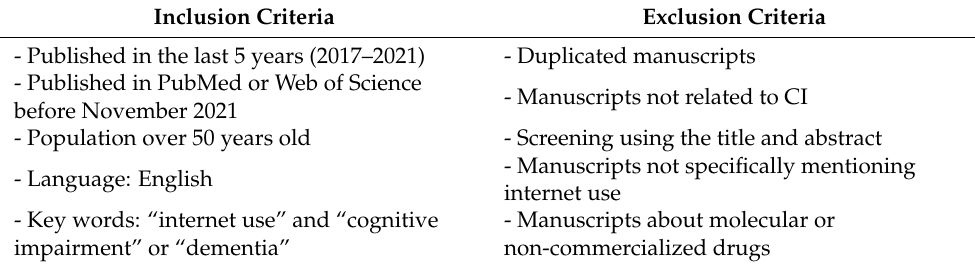
Table 1. Inclusion and exclusion criteria for the bibliographic